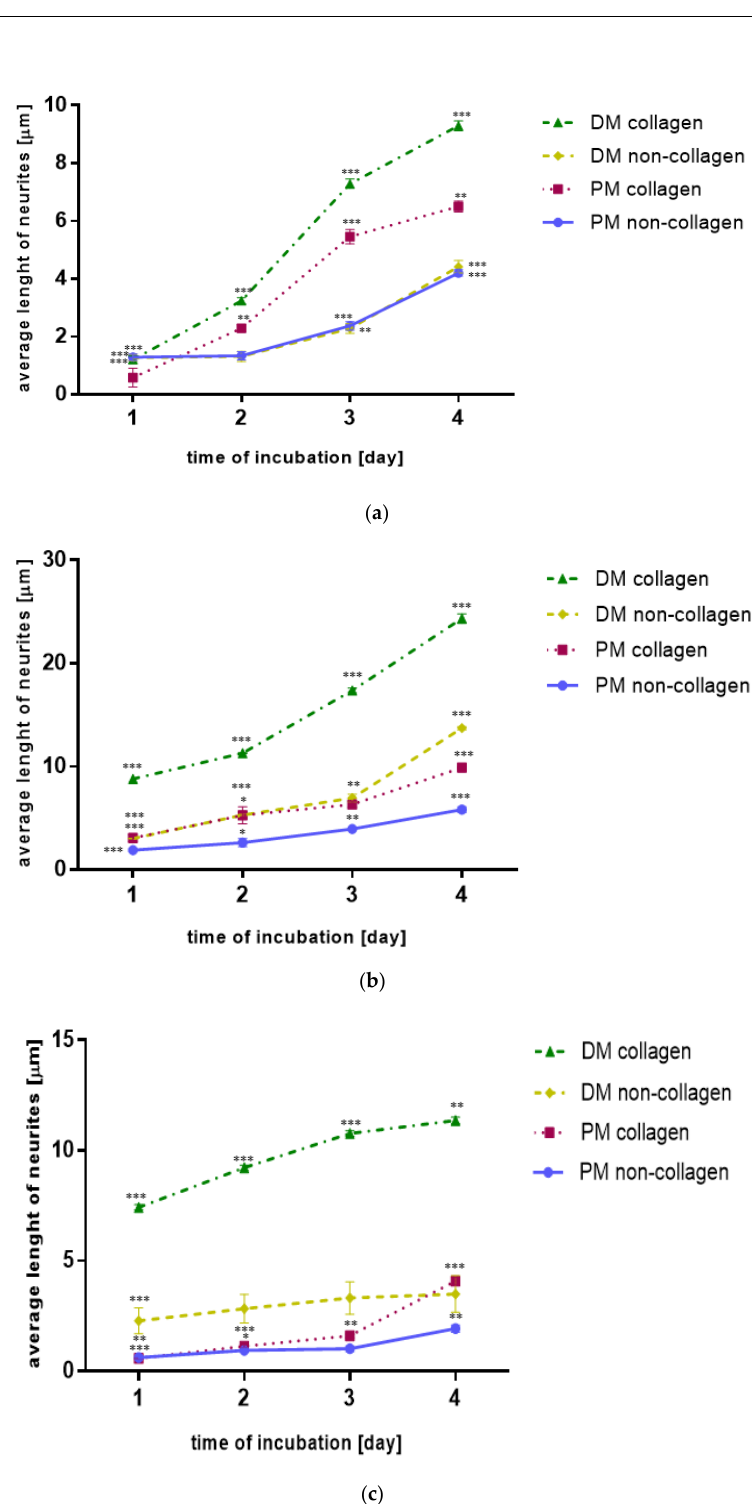
Figure 1. ( a ) The influence of the medium type and the addition of collagen on SH-SY5Y cells neurites length. Results are presented as mean values ± SD. Differences *** p < 0.001; ** p < 0.01 were deemed statistically significant. ( b ) The influence of vibration with frequency of 40 Hz, the medium type and the addition of collagen on SH-SY5Y cells neurites length. Results are presented as mean values ± SD. Differences *** p < 0.001; ** p < 0.01, * p < 0.05 were deemed statistically significant. ( c ) The influence of vibration with frequency of 100 Hz, the medium type and the addition of collagen on SH-SY5Y cells neurites length. Results are presented as mean values ± SD. Differences *** p < 0.001; ** p < 0.01, * p < 0.05 were deemed statistically significant.